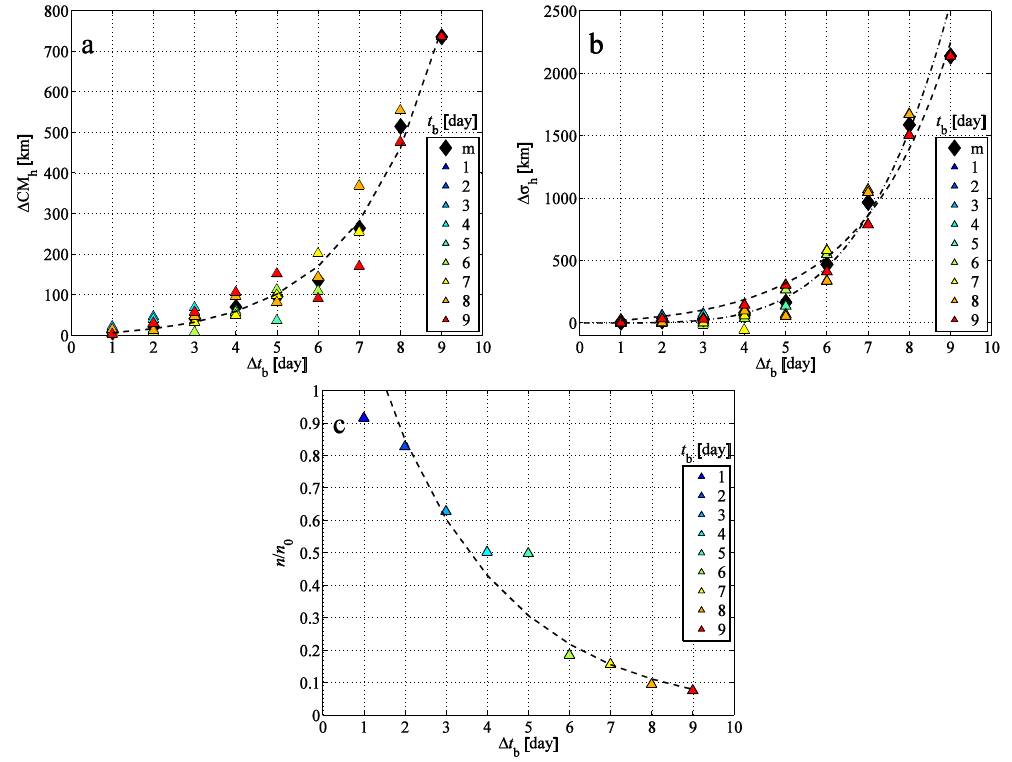
Figure 5. ( a ) The horizontal difference ∆ CM h between the center of mass of the BWCs and the FWC depending on the time period ∆ t b of the backward simulation; ( b ) the difference ∆ σ h between the horizontal standard deviations of the BWCs and FWC; ( c ) the proportion n / n 0 of the particles returned back to the initial cuboid. Colored triangles indicate the starting time t b of the backward simulations (see color legend); black diamonds (in some cases in overlap with triangles) are the mean values belonging to a given ∆ t b (denoted by “m”). Dashed lines indicate exponential fits to the mean values; the exponents are given in Table 1. The dash-dotted line in panel (b) indicates a power-law fit to mean values over the interval ∆ t b = 3–9 days with an exponent of